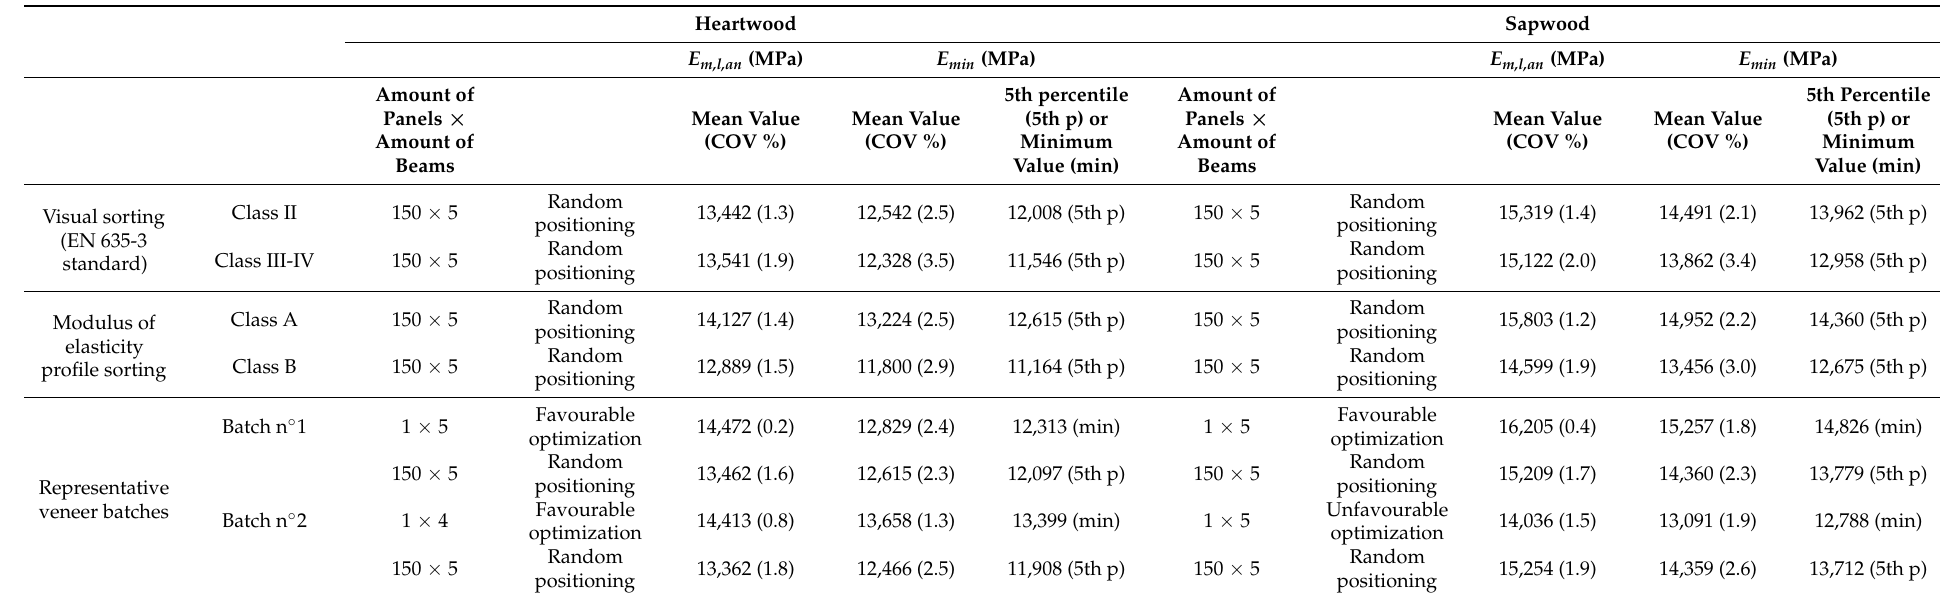
Table 7. Summary results (12%